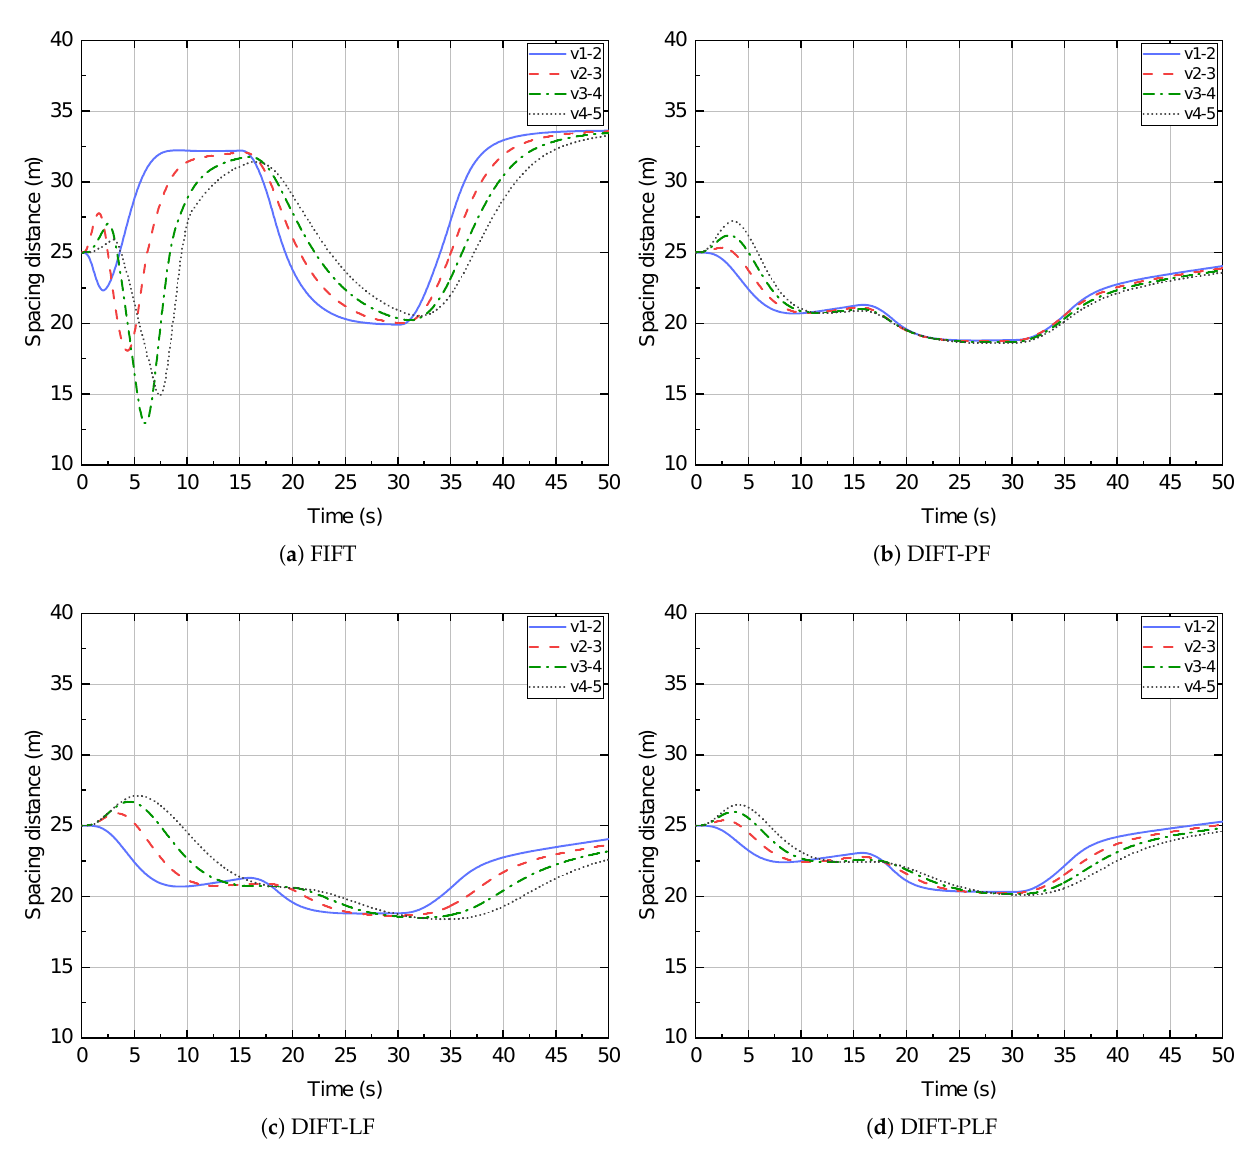
Figure 9. Space distances between adjacent vehicles.